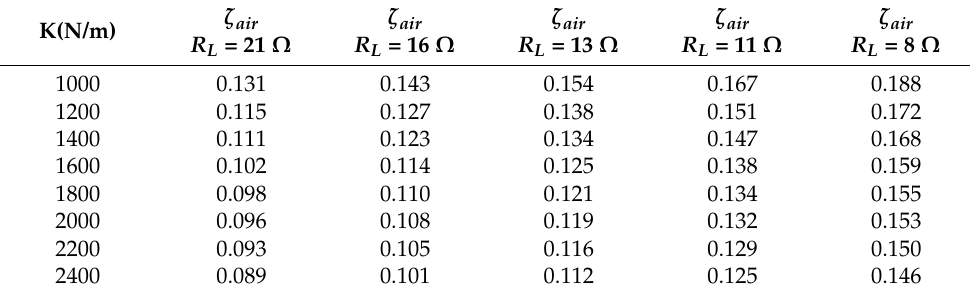
Table 2. The results of free decay test